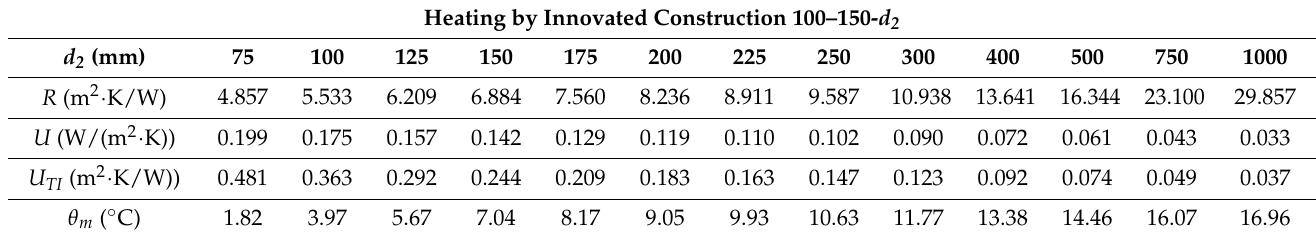
Table 3. Results of calculation of physical variables during the heating season.